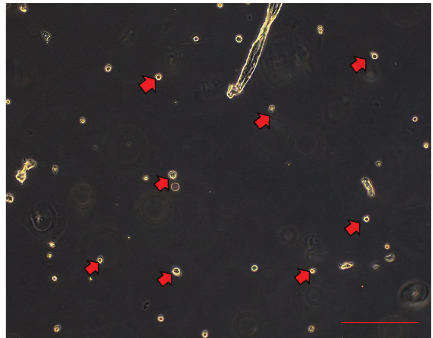
Figure 12: Sphere formation assay on OSA3-CSCs. After 24h from the start of the assay, cells appear floating and isolated from each other (cells are indicated by the black/red arrows). Observation in phase contrast. Original magnification: 10x. Bar size: 100 𝜇 m.